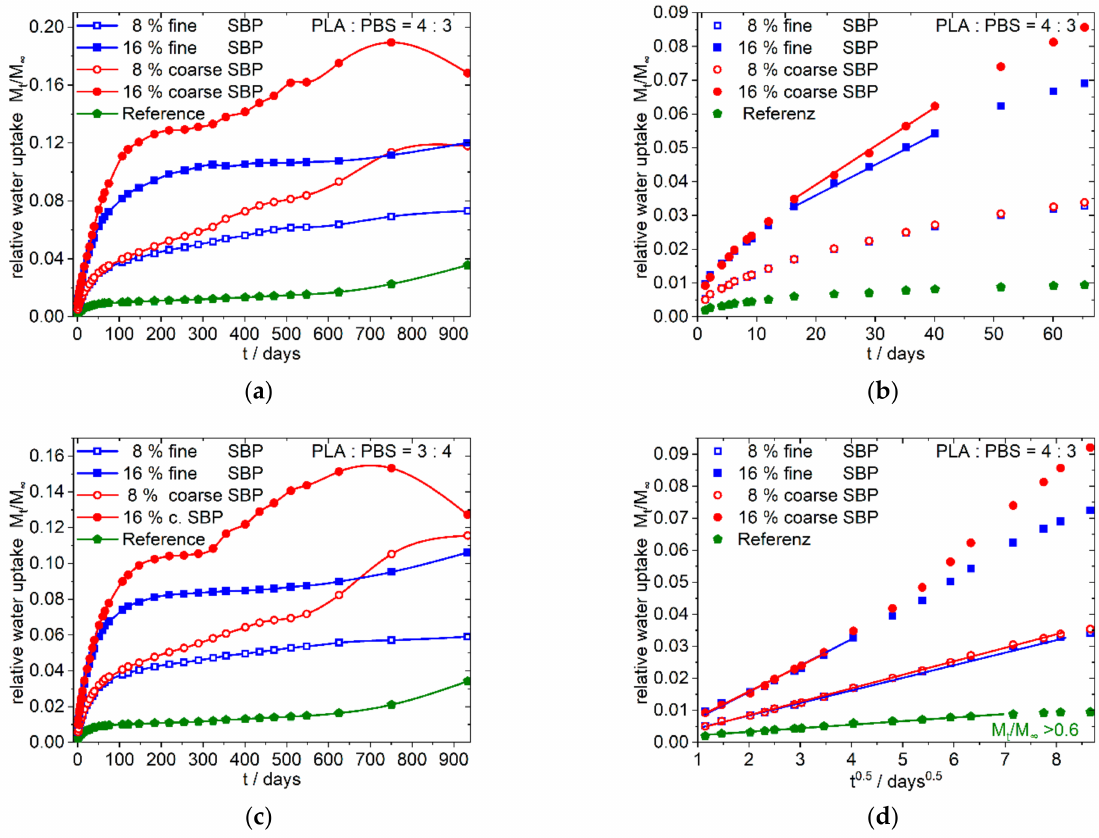
Figure 5. Water uptake of the 4:3/3:4-f/c-8/16-1.0 Composites; ( a , c ) overview, linear dependence from time; ( b ) enlargement of ( a ) for the first 70 days; ( d ) enlargement of ( a ) of the first 70 days showing the dependence of water uptake from the square root of time. The nearly identical shaped graphs for the 3:4-f/c-8/16-1.0 composites analogous to ( b , d ) is shown in the supplementary materials (Figure